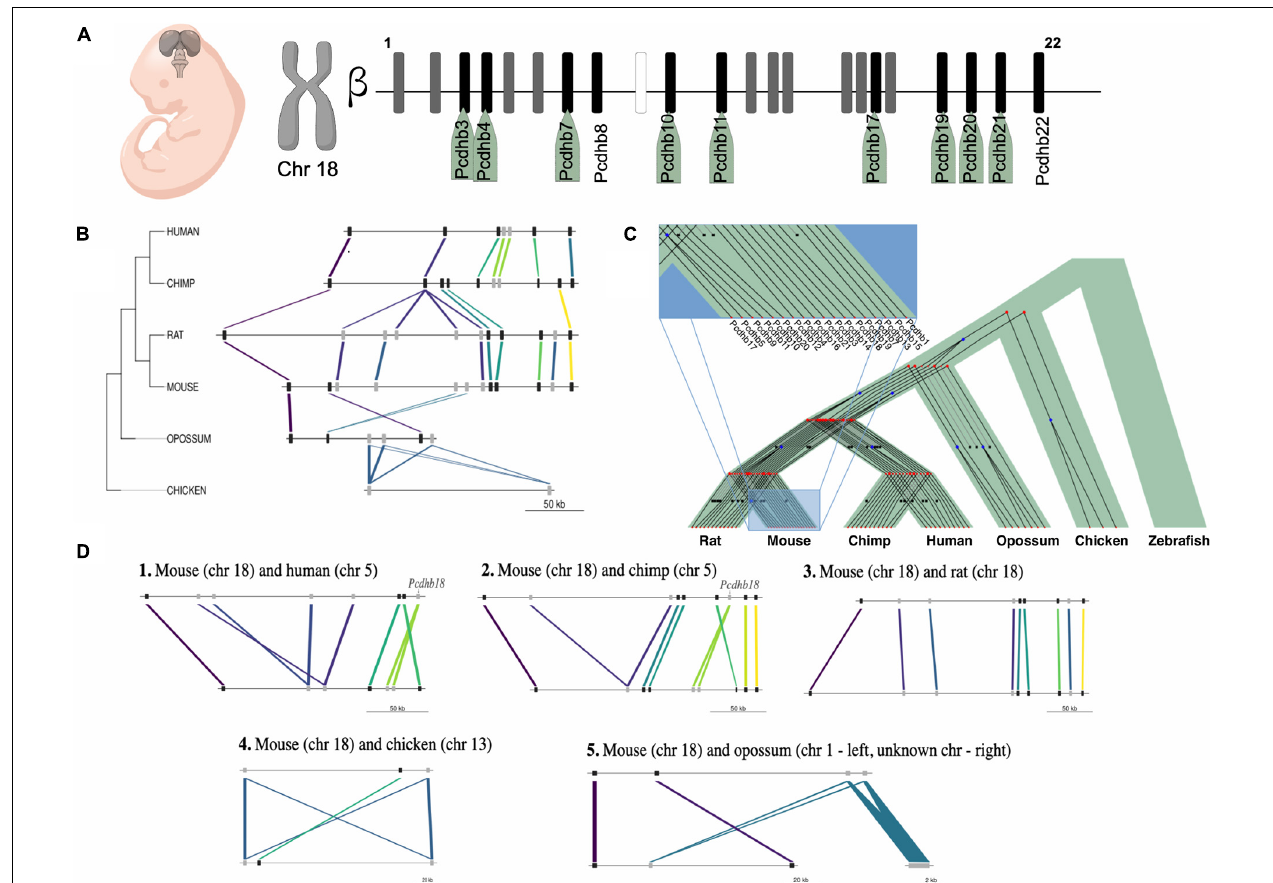
FIGURE 7 | Expression and evolution analysis of the mouse cluster of β -protocadherins. (A) Cluster of the 22 β -protocadherins in the chromosome 18 depicting in black up-regulated genes (names highlighted in green) in telencephalon between embryonic stages 9.5 and 10.5, in gray expressed genes with no relative changes between stages, and in white not expressed genes; (B) Syntenic map of the approximately 300 kb β -protocadherin locus across five mammalian lineages and chicken as an outgroup. Colored lines depict orthology relationships across the phylogenetic tree. Genes connected by the same color belong to the same orthogroup identified by ProteinOrtho. Genes are shown as black squares for single-copy orthologs and gray squares for expanded genes; (C) Reconciliation tree of the protocadherin gene trees and the species tree. Each gene tree represents an orthogroup, internal nodes represent evolutionary events (blue squares represent duplications, red bullets represent speciations) and black crosses in leaves represent inferred gene loss events; (D) Pairwise syntenic comparisons of the mouse β -protocadherin locus to four mammalian genomes and chick highlighting the lineage-specific loss and expansions of the Pcdhb18